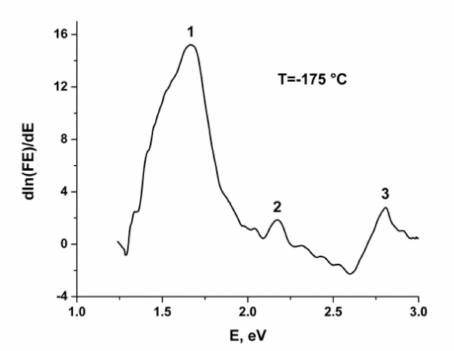
Figure 3. Dependence of dln(F(R) · E) / dE on energy at − 175 ◦